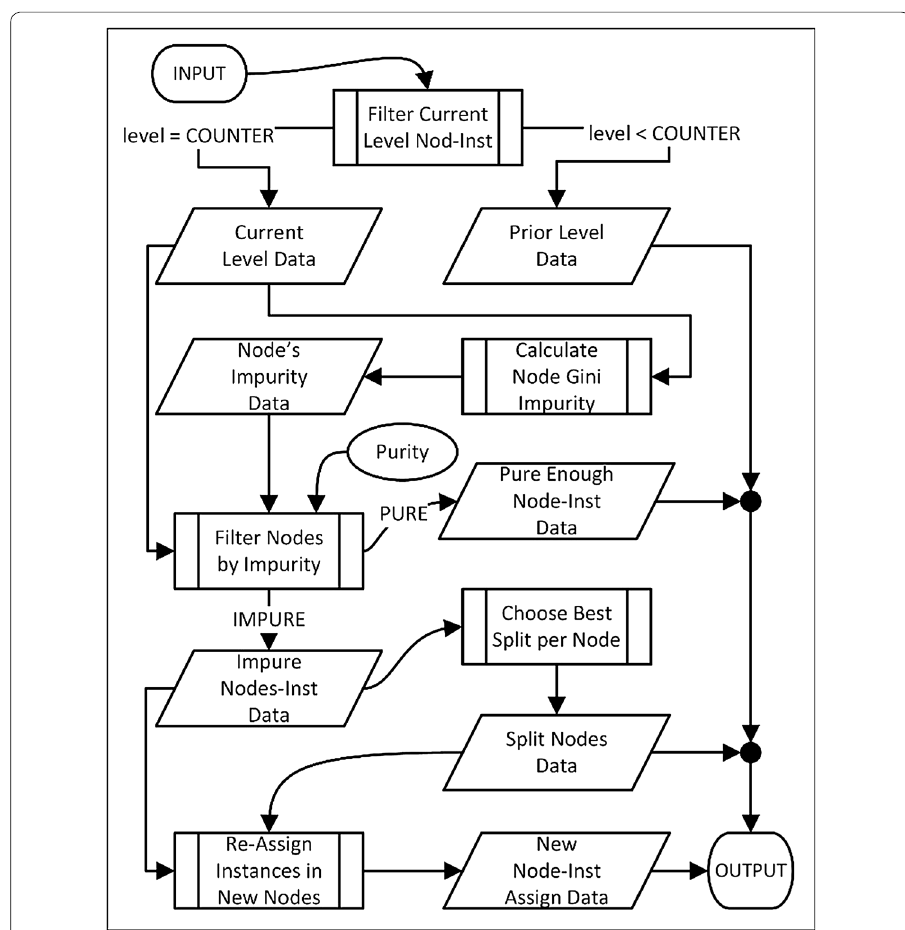
Fig. 4 Decision Tree split/partition function